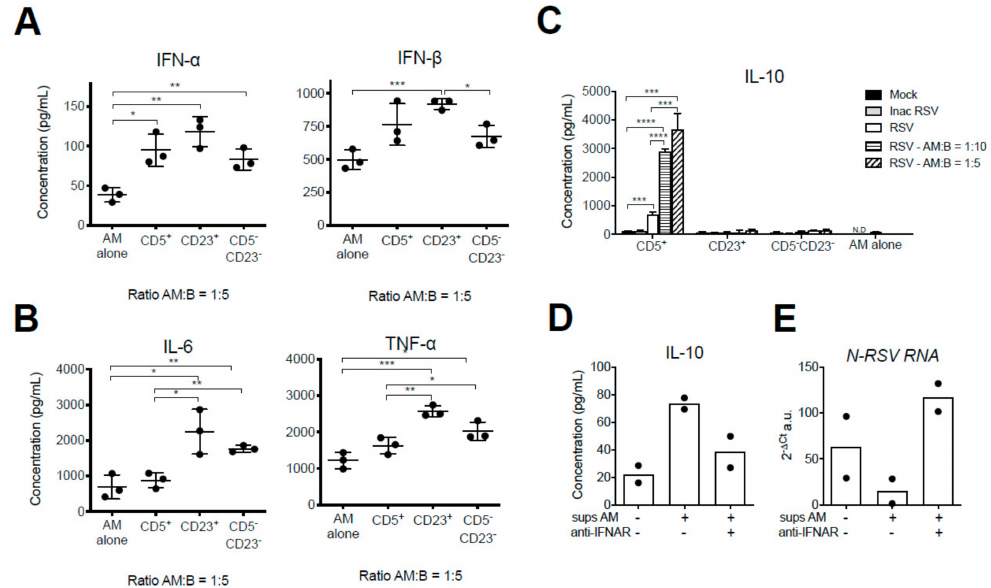
Figure 5. The IFN-I response of neonatal AMs to RSV enhanced IL-10 production by CD5 + B-cells. ( A , B ) Neonatal primary AMs (1 × 10 4 cells / well, MOI = 5) were infected for 48 h with RSV-mCherry alone or in the presence of FACS-sorted CD5 + , CD5 − CD23 + , or CD5 − CD23 − B-cells (5 × 10 4 B-cells / well, ratio AMs:B-cells = 1:5) isolated from the lungs of 6 day-old BALB / c mice (pool of n = 50). ( A ) IFN- α and IFN- β , and ( B ) IL-6 and TNF- α productions were determined by luminex assays in cellular supernatants. ( C ) CD5 + , CD5 − CD23 + , or CD5 − CD23 − B-cells isolated from the lungs of 6 day-old BALB / c mice (5 × 10 4 cells / well, pool of n = 50) were infected for 48 h with RSV-mCherry, UV inactivated-RSV-mCherry (Inac RSV, MOI = 5), or Mock control, alone or in the presence of neonatal primary AMs at di ff erent ratios (5 × 10 3 or 1 × 10 4 AMs / well, ratio AMs:B-cells = 1:10 or 1:5). IL-10 production was measured by luminex assays in cellular supernatants. ( D – E ) FACS sorted CD5 + B-cells were infected for 48 h in the presence of conditioned supernatant from RSV-infected neonatal primary AMs in the presence or absence of anti-IFNAR antibody. ( D ) IL-10 secretion was measured in supernatant by luminex. ( E ) Infection was analyzed by measurement of viral N-RSV RNA expression by qRT-PCR from cell lysates. Results are expressed ( A , D , E ) mean of triplicate ± SEM (one representative experiment